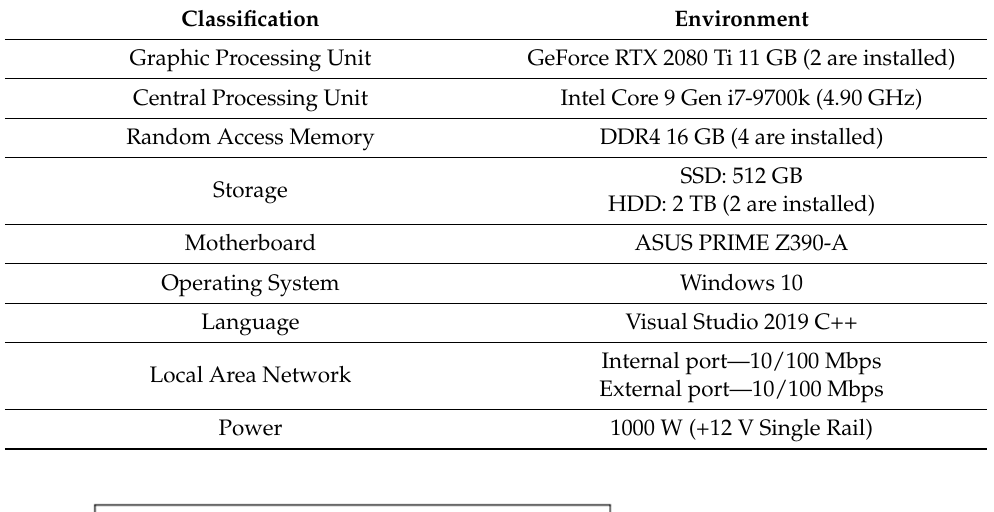
Table 4. The detailed specifications of the experimental setup.